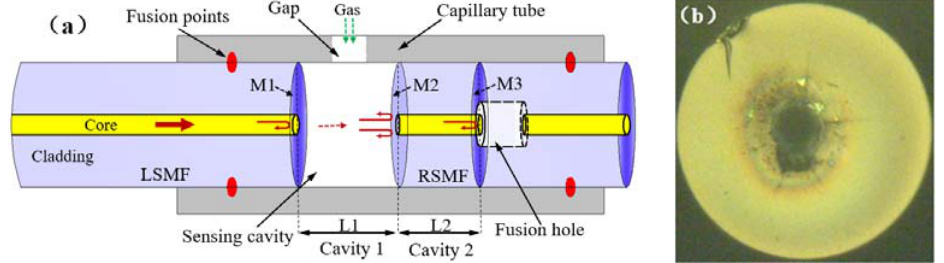
Figure 1. ( a ) Schematic of proposed sensor structure; ( b ) microscope image of fusion hole on the end face of fiber.